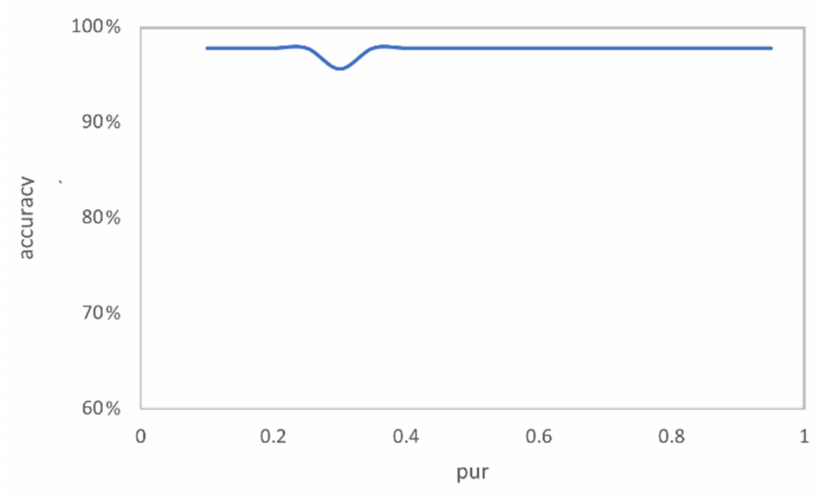
Figure 9. The classification accuracy under different pur